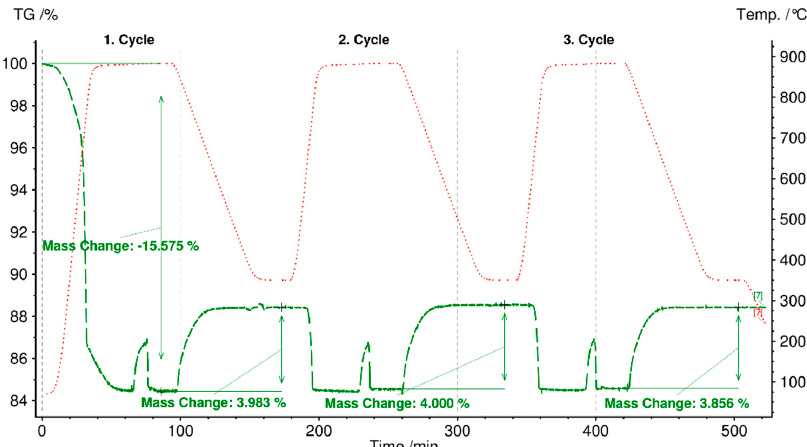
Figure 11. Cycling stability test of fly ash C-boiler heated to 800 °C at a heating rate of 30 °C/min in a N 2 atmosphere (charging step) and cooled from 800 °C to 350 °C at a cooling rate of 10 °C/min in CO 2 (100 ml/min) and H 2 O (1 g/h) atmosphere.